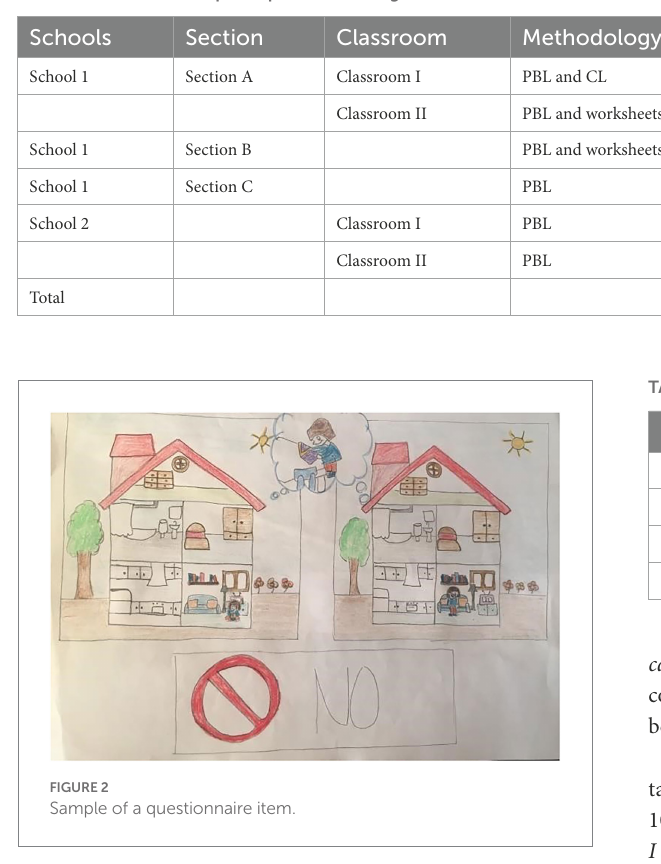
TABLE 2 Distribution of participants according to their sex and